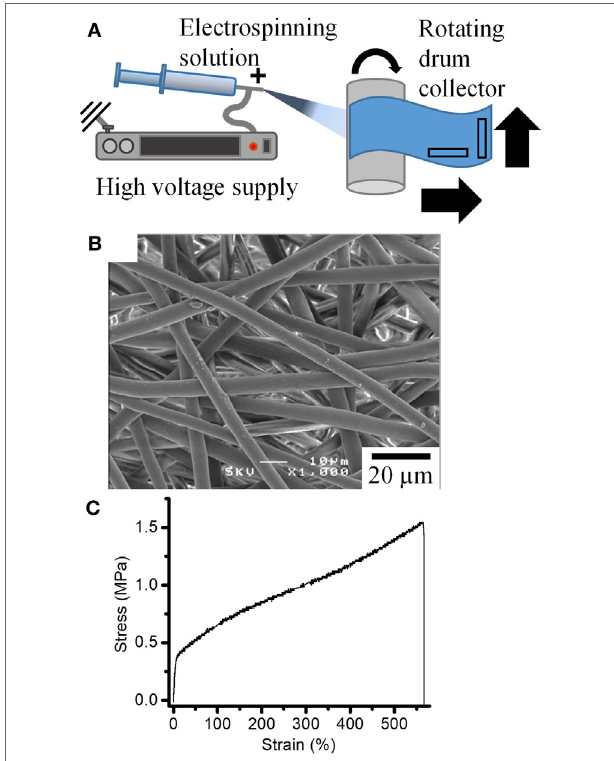
FigUre 1 | (a) Schematic of electrospinning setup used to produce fiber mats. (B) SEM image of the fiber mats obtained. (c) Typical stress–strain curves for the tensile deformation of the fiber